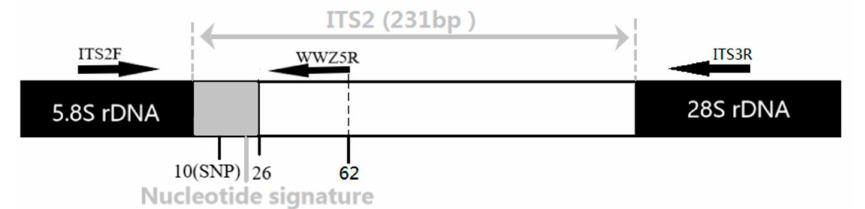
Figure 2. Schematic diagram showing the location of primer pairs (ITS2F / WWZ5R, ITS2F / ITS3R) and the nucleotide signature region of S. chinensis